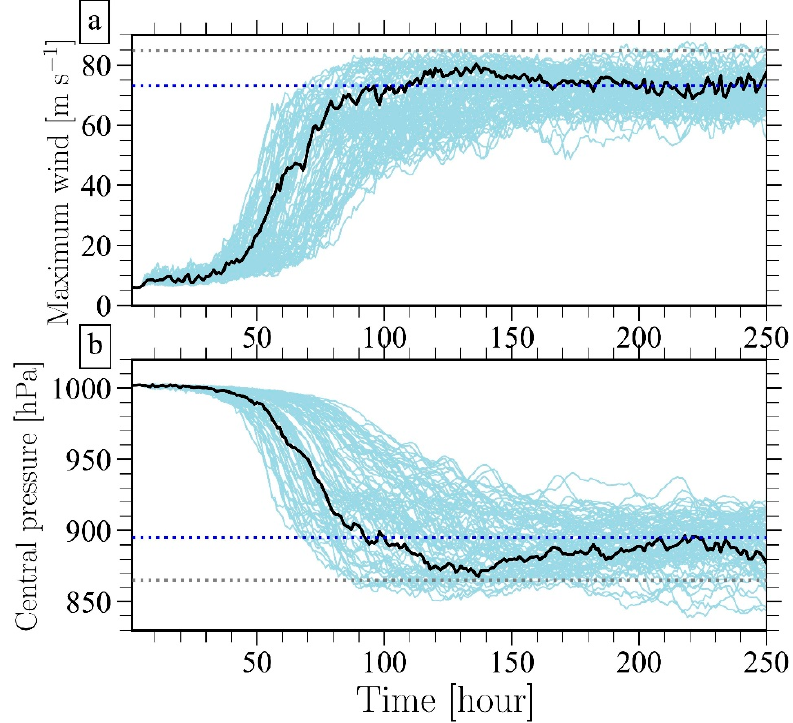
Figure 3. Temporal change in the ( a ) maximum wind speed and ( b ) central surface pressure of the simulated TCs. The black and sky-blue lines show the results of the CTL experiment and the sensitivity experiments, respectively. The blue and gray dotted lines indicate the maximum intensity of Typhoon Vera (1959) from the JMA and JTWC best track, respectively.